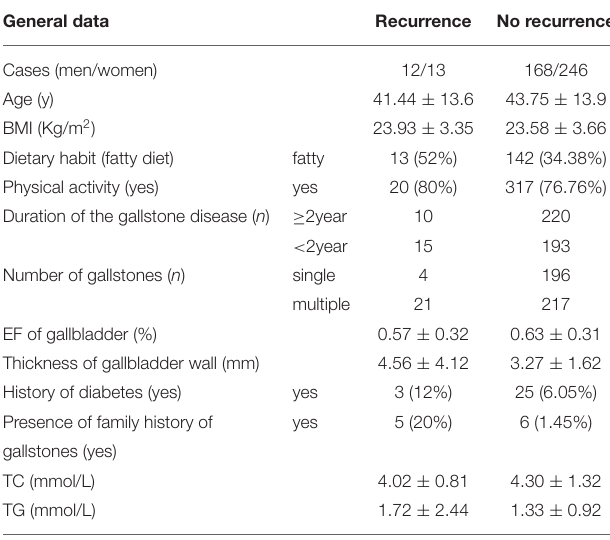
TABLE 1 | Patients’ general clinical data ( n = 438).